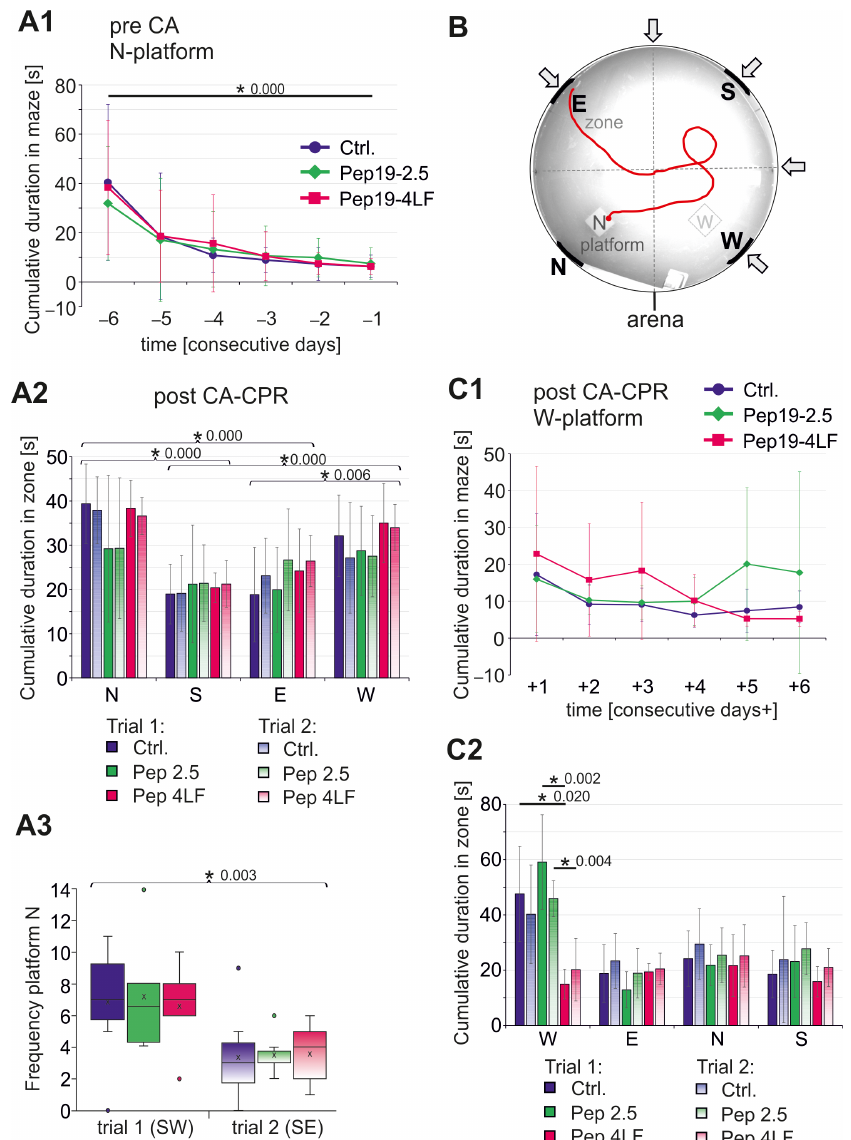
Figure 4. Testing of spatial learning and memory using the water maze task. (1, 2) given as mean ± SD and (3) were presented as boxplots showing the quartiles, the 5th and 95th percentiles (whiskers), the median (line) and the mean (x). ( A1 ) Cumulative duration in maze during the learning phase pre-CA using platform at N position. In all groups, the mice have learned where the invisible platform was placed (d –6 vs. d –1: p = 0.000). ( A2–3 ) Spatial probe post-CA-CPR without N-platform. ( A2 ) The cumulative duration in the individual zones of the arena without N-platform (first and second trials) was not different between zone N vs. W and zone S vs. E. But all other comparisons of cumulative durations in the zones showed significant differences ( p -values see A2). ( A3 ) Frequency at which the position of the platform was directly swum through during a 2 min time in the water maze. Significance tested between Trial 1 and Trial 2 ( p = 0.003). ( B ) Sample photo of mouse tracking (red line) on learning day 3 in the arena showing zones (N, S, E, W), position of invisible platform (N) and different starting positions (arrows) used in alternating. ( C1 ) Cumulative duration in maze during the learning phase post-CA-CPR using position of Platform W. ( C2 ) Spatial probe post-CA-CPR without W-platform. Cumulative duration in the individual zones of the arena without W-platform.